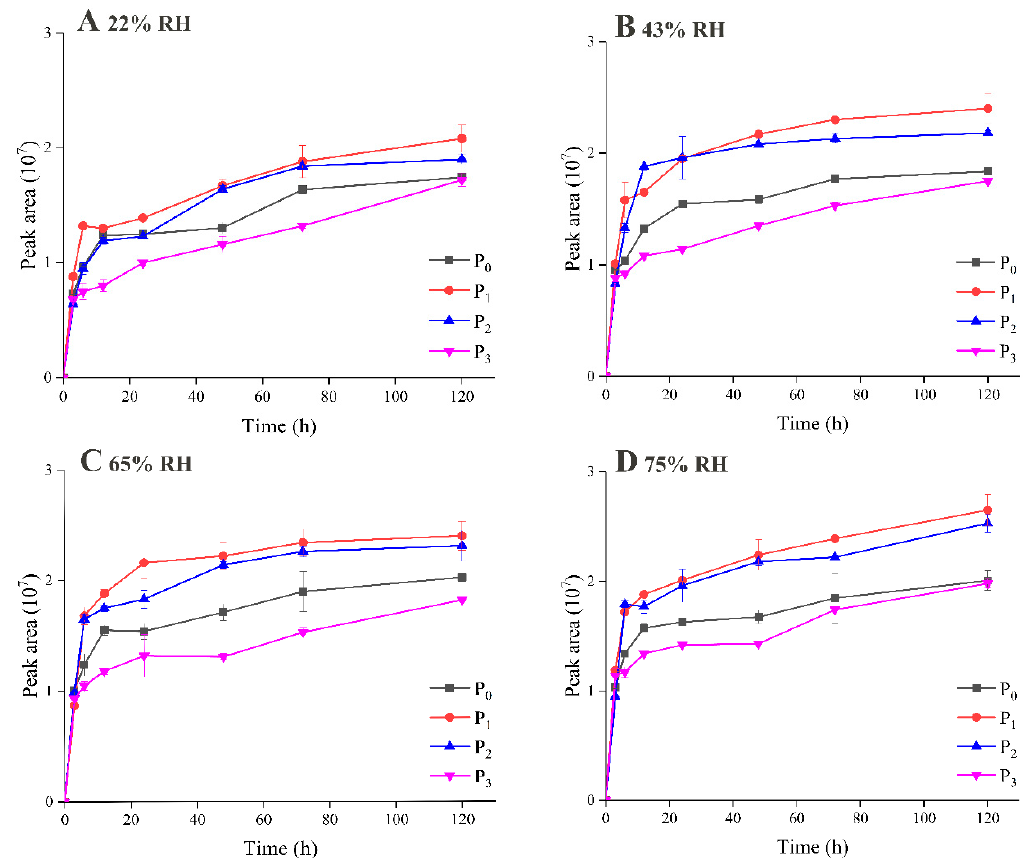
Figure 4. Ethyl acetate (EA) release of powder microcapsules at relative humidity (RH) 22% ( A ), 43% ( B ), 65% ( C ), 75% ( D ) during storage.